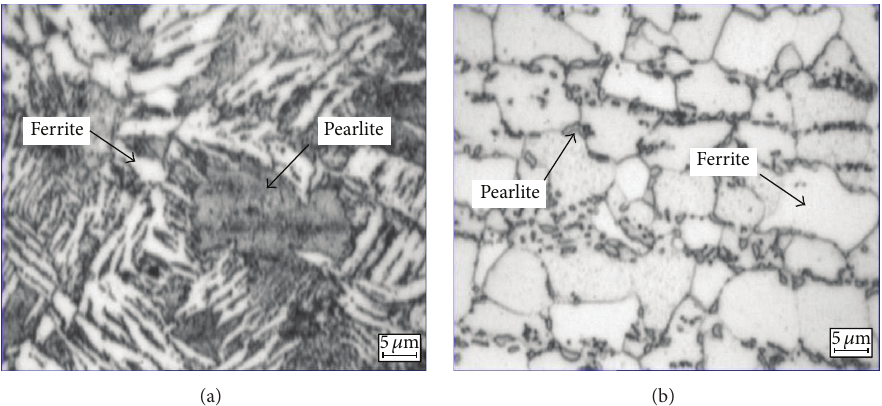
Figure 6: HAZ microstructure of sample in a PWHT with (a) PWHT temperature of 645 ∘ C and PWHT time of 5 hr and (b) PWHT temperature of 670 ∘ C and PWHT time of 25